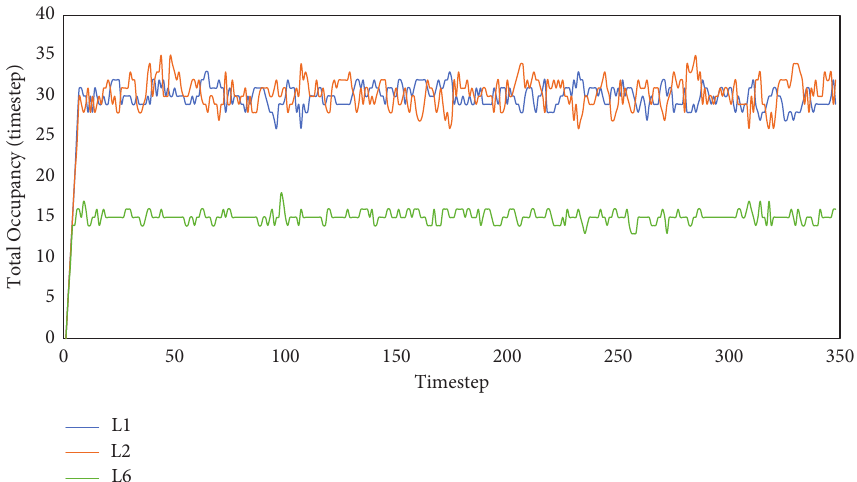
Figure 6: Comparison of the total occupancies over time for different